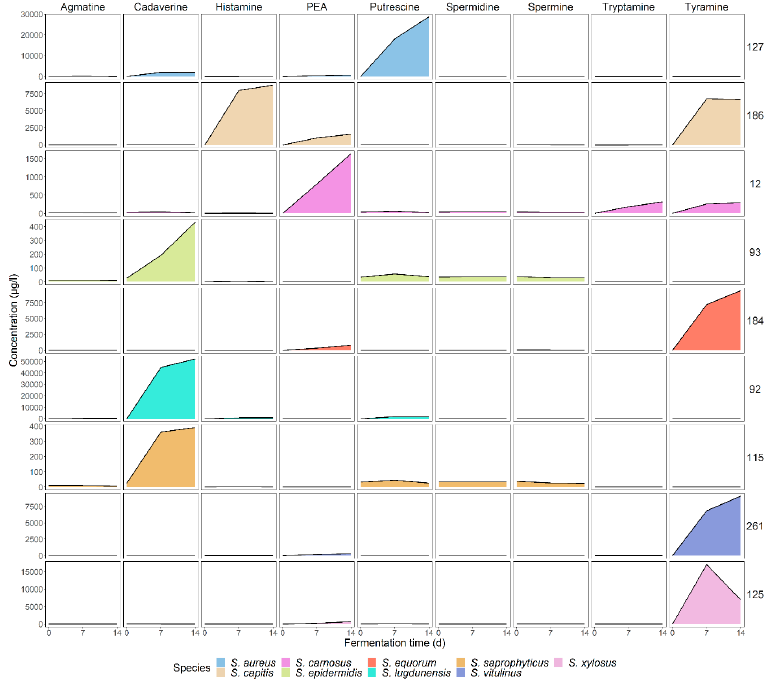
Figure 4. Biogenic amine profiles of fermentations in BHI broth at 30 °C during 14 d. Only selected strains are shown, namely S. aureus IMDO-S127, S. capitis IMDO-S186, S. carnosus IMDO-S12, S. epidermidis IMDO-S93, S. equorum IMDO-S184, S. lugdunensis IMDO-S92, S. saprophyticus IMDO-S115, S. vitulinus IMDO-S261, and S. xylosus IMDO-S125. Scaling for each depicted strain was adapted to improve the readability of the corresponding